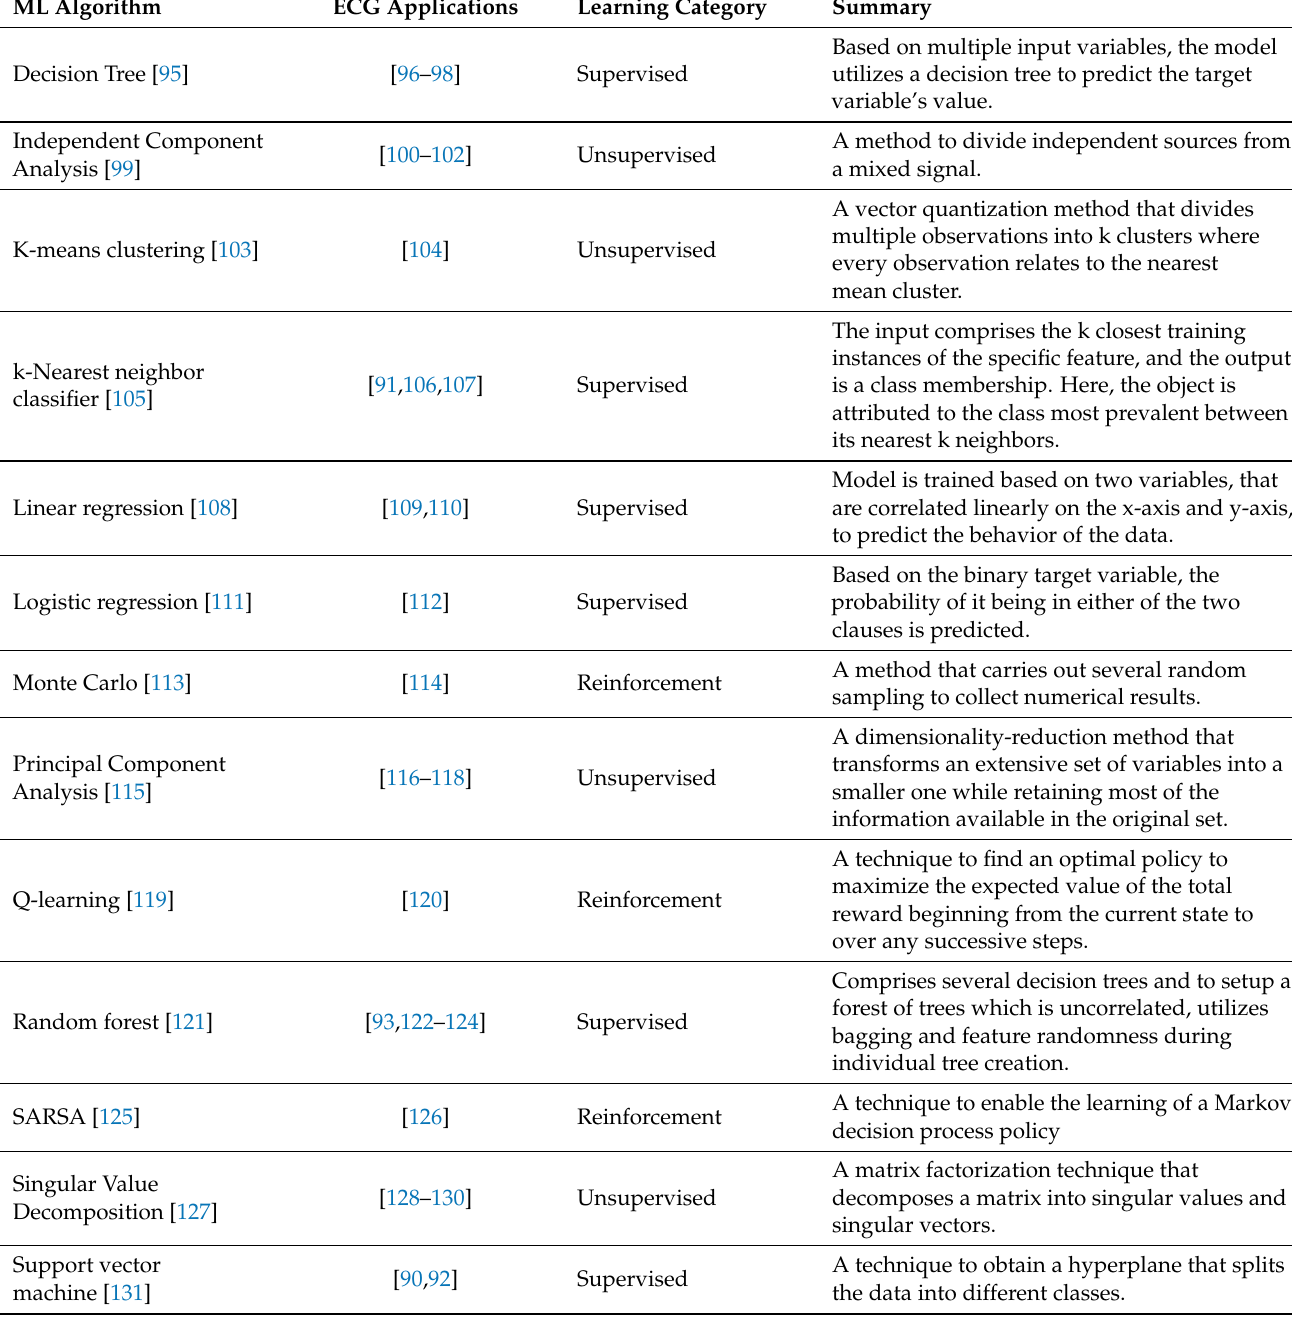
Table 3. Summary of commonly used machine learning (ML)